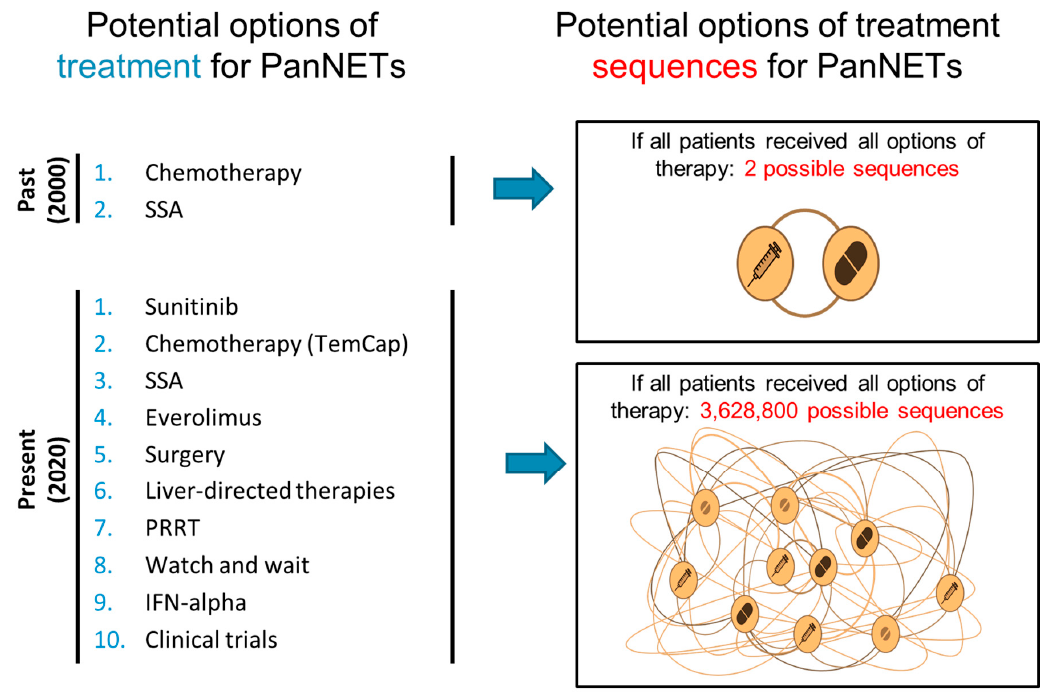
Figure 3. As options of treatment increase, potential sequencing alternatives grow exponentially making it di ffi cult for clinical trials to explore each potential sequencing option. PanNETs—pancreatic neuroendocrine tumours; SSA—somatostatin analogue; TemCap—temozolomide and capecitabine; and, PRRT—Peptide receptor radionuclide therapy IFN- interferon.